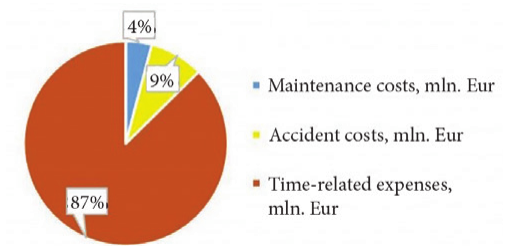
Fig. 8. The total losses incurred by the society in 2011–2014 winter